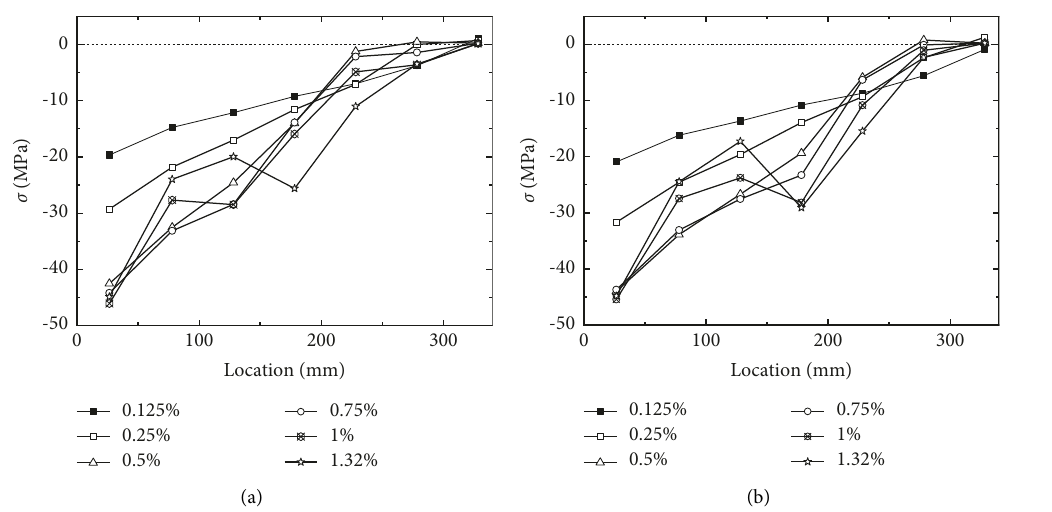
Figure 21: Concrete stress distributions of core walls with varied axial compression ratios. (a) n � 0.2, l / h � 1.5. (b) n � 0.3, / h �